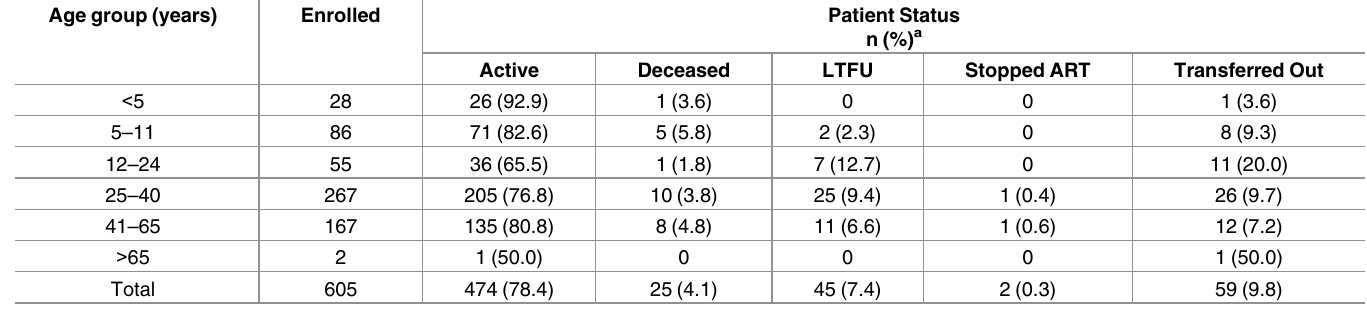
Table 3. Attrition rates as at time of analysis stratified by baseline age groups (N =